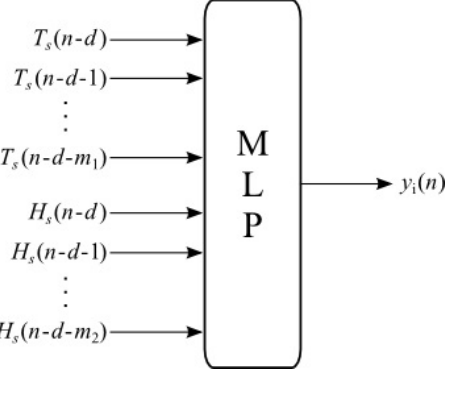
Figure 8. Structure of the MLP inferential system.